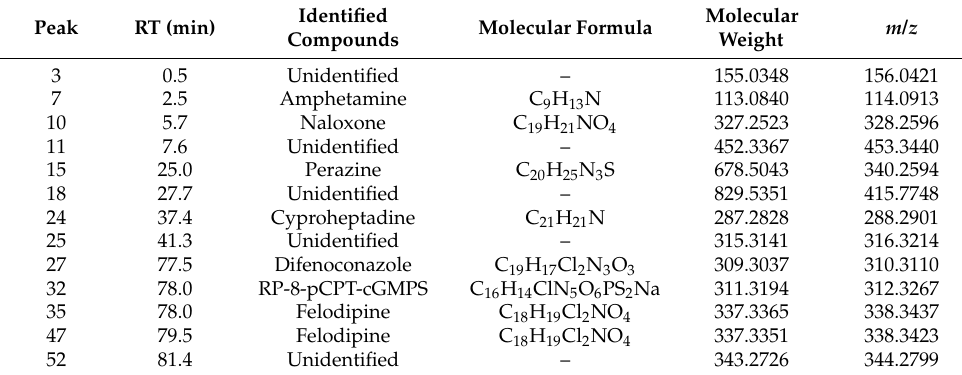
Figure 8. Chemical structures of papaverine. Figure 9. Chemical structures of sparteine. Non-alkaloids (pharmaceutical compounds) are highlighted in Table 11. Previous studies on biological activities have shown that anticonvulsant drugs contain loprazolam [65], phenytoin [66], and thiopental [67] compounds. Moreover, amphetamine [68], nalox- one [69], and perazine [70] have been found in antidepressant drugs. Antifungal drugs also contain difenoconazole [71], econazole [72], and penconazole [73] compounds. Bio- logical activities in antihistamine, antihypertensive, anti-inflammatory, and antipsychotic drugs have been associated with cyproheptadine [74], felodipine [75], L-histidine [76], and pimozide [77] compounds. Stimulant laxatives, antimicrobials, anaesthetic drugs, and dye